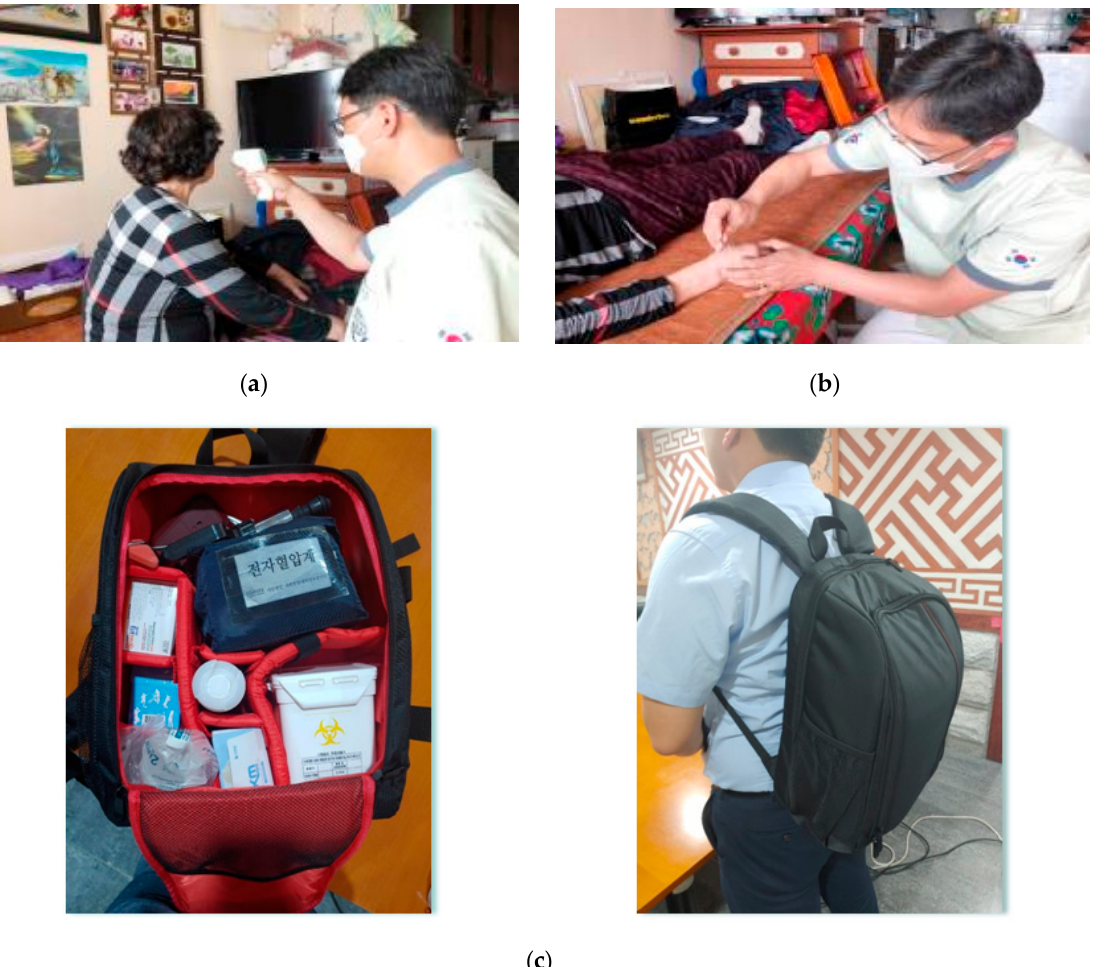
Figure 2. The process of TKM community home care. TKM: Traditional Korean medicine. ( a ) Body temperature check before treatment, ( b ) Acupuncture intervention, ( c ) TKM home care bag.